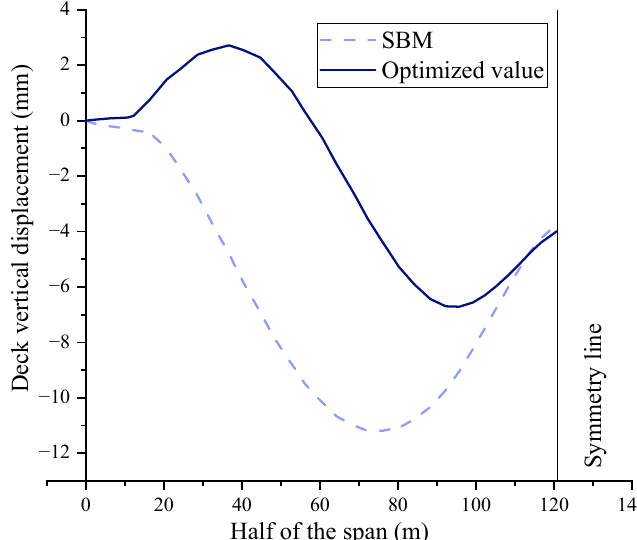
Figure 16. Vertical displacement of the optimized main beam.